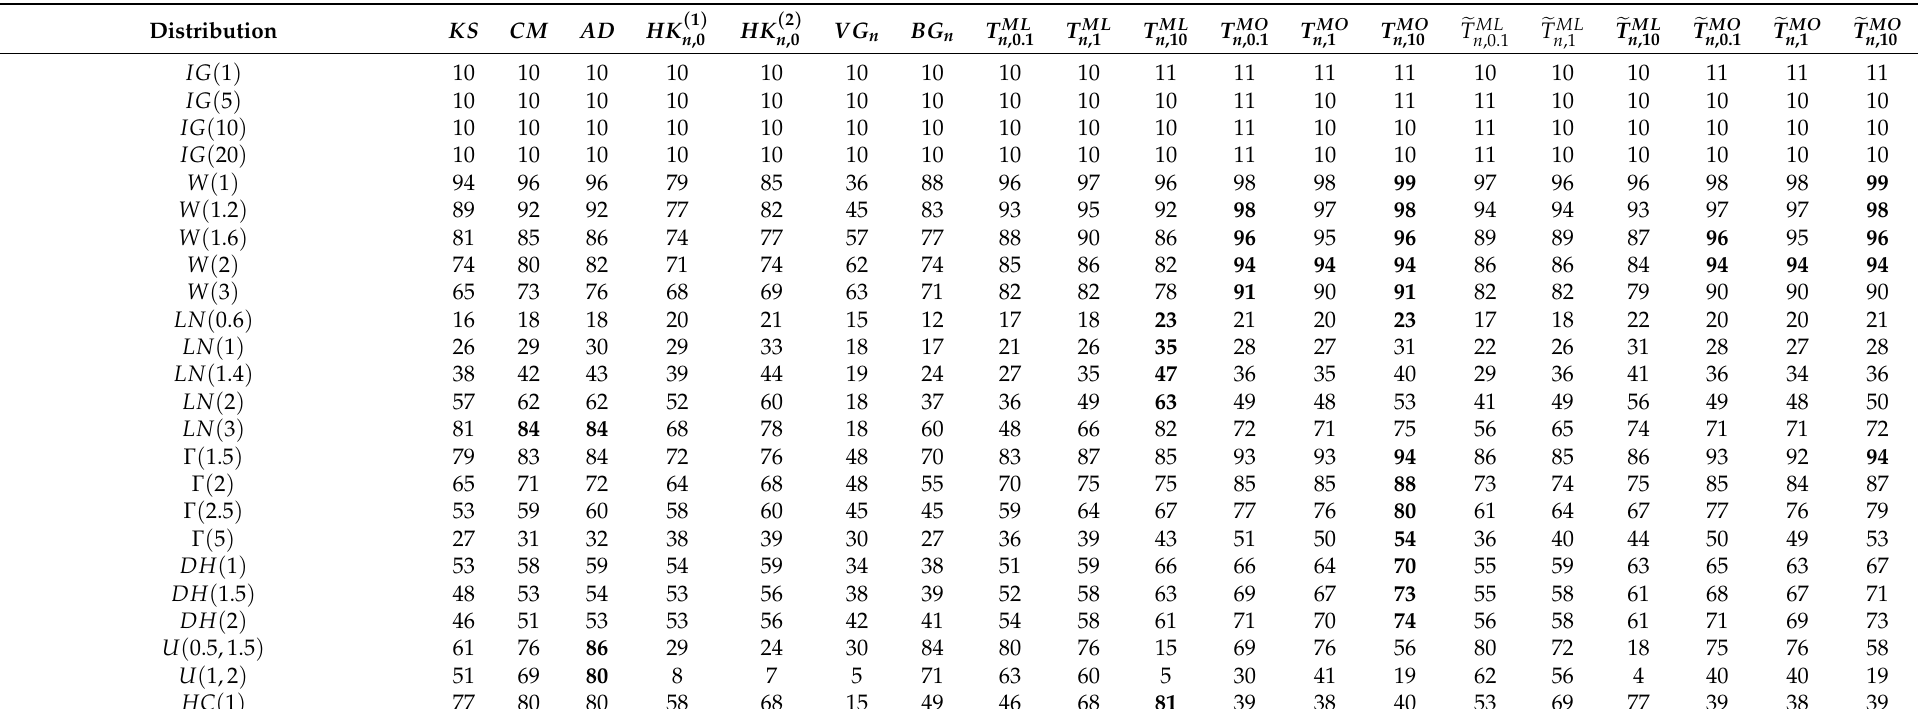
Table 3. Approximated powers for sample size n =